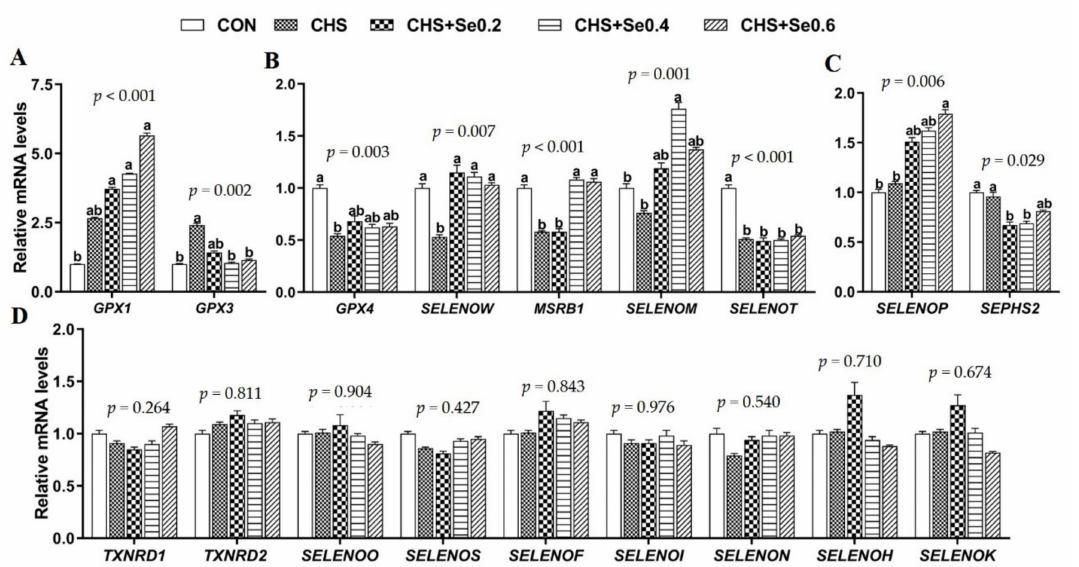
Figure 6. Effects of CHS and OH-SeMet supplementation on expression of selenoprotein encoding genes in longissimus dorsi muscle ( A – D ). The results are expressed as Mean ± SEM ( n = 6). Different letters (a, b, c, d) denote significant differences ( p <